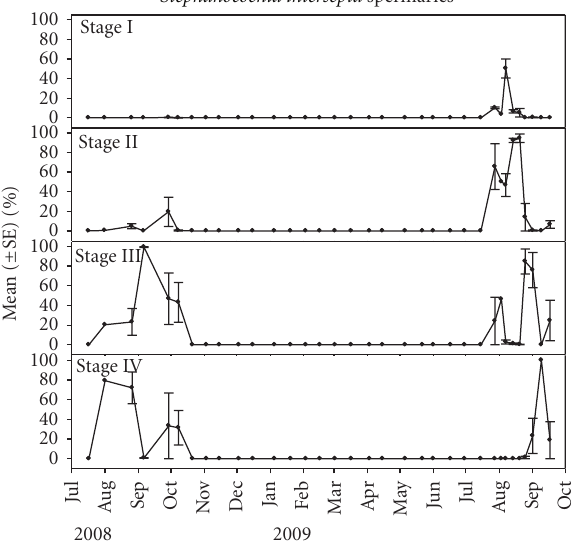
Figure 11: Stephanocoenia intersepta mean ( ± SE) percentages of spermaries per colony quantified through histological